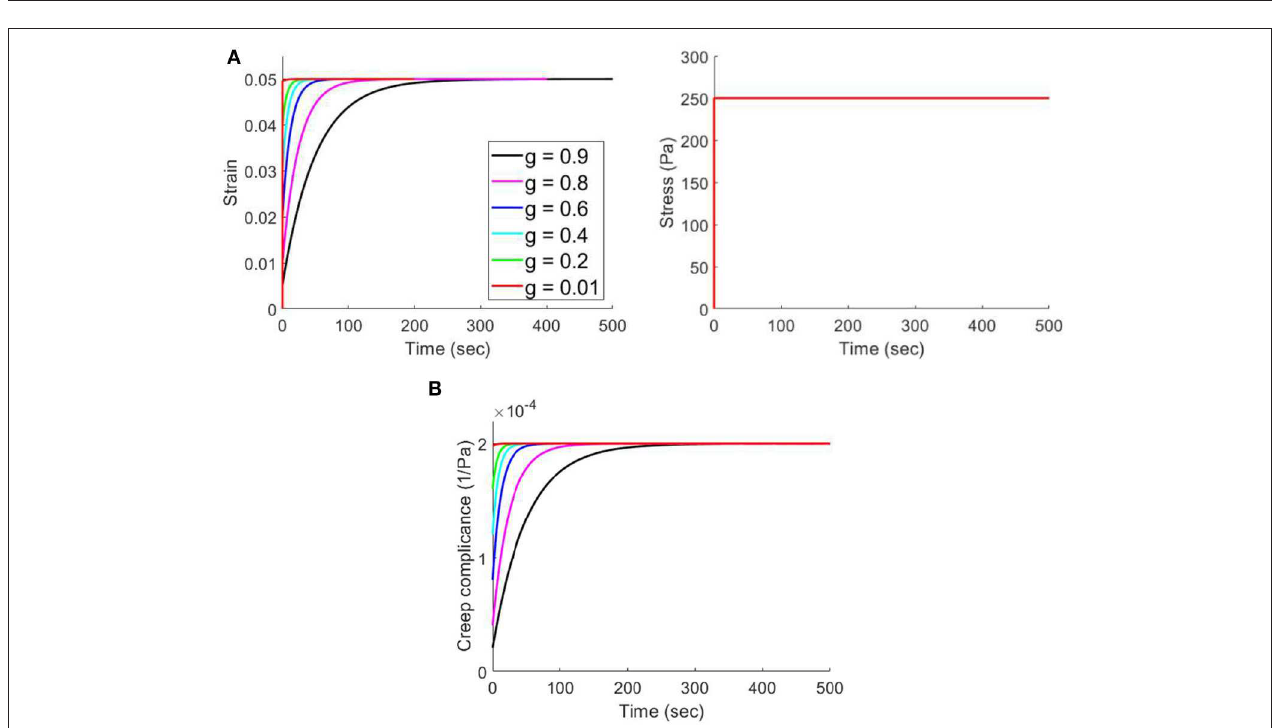
FIGURE 9 | (A) Strain and stress responses over time of different materials in the group 3 during the creep test. (B) Corresponding creep compliance.